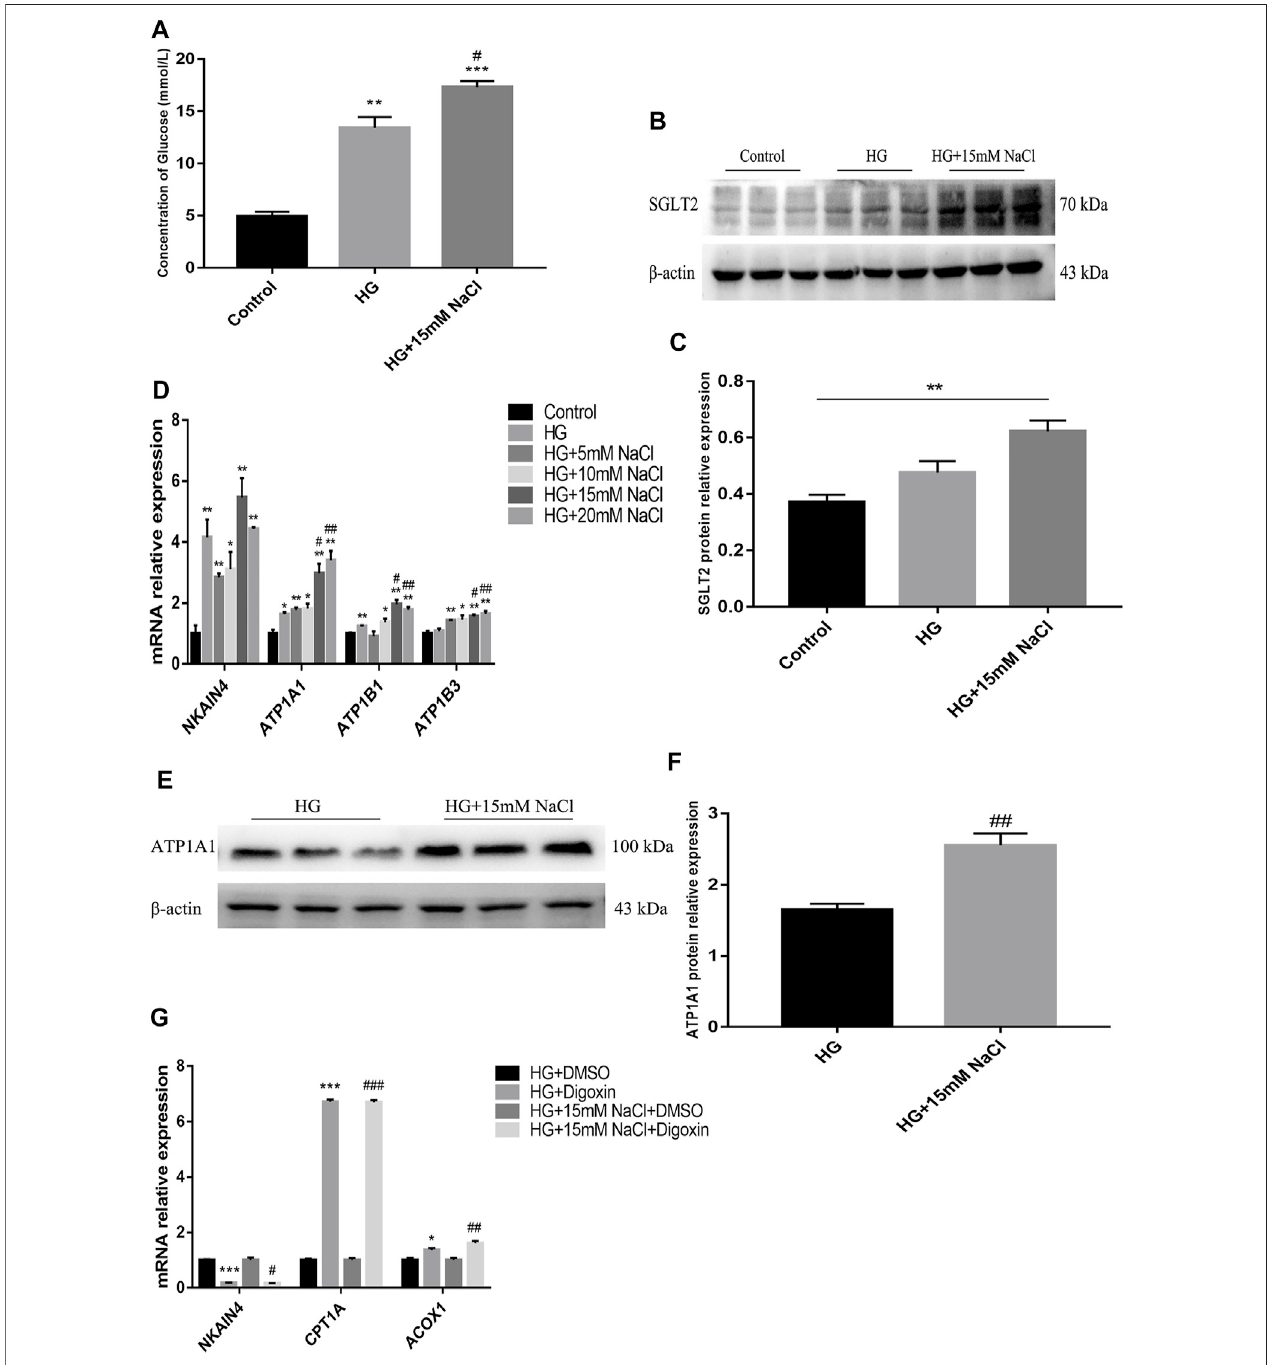
FIGURE 6 | High salt alters SGLT2 and Na+/K + -ATPase expression in HG-treated HK-2. (A) Intracellular glucose concentration. (B,C) Expression of SGLT2 in HK-2 in HK-2 cultured with HG and 15 mM NaCl. (D) Expression of NKAIN4, ATP1A1, ATP1B1 and ATP1B3 genes in HK-2 after exposure to HG and different concentrations of NaCl. (E,F) Expression of ATP1A1 protein in HK-2 with HG and 15 mM NaCl cultured. * p < 0.05, ** p < 0.01 and *** p < 0.001 vs. Control group; # p < 0.05 and ## p < 0.01 vs. HG group. (G) Expression of NKAIN4 and fatty acid metabolism related genes were detected in HK-2 treated with Digoxin. * p < 0.05 and *** p < 0.001 vs. DM + DMSO group; # p < 0.05, ## p < 0.01 and ### p < 0.001 vs. HG + NaCl + DMSO group. All data are mean ± SEM, n (cid:1) 3 per group.